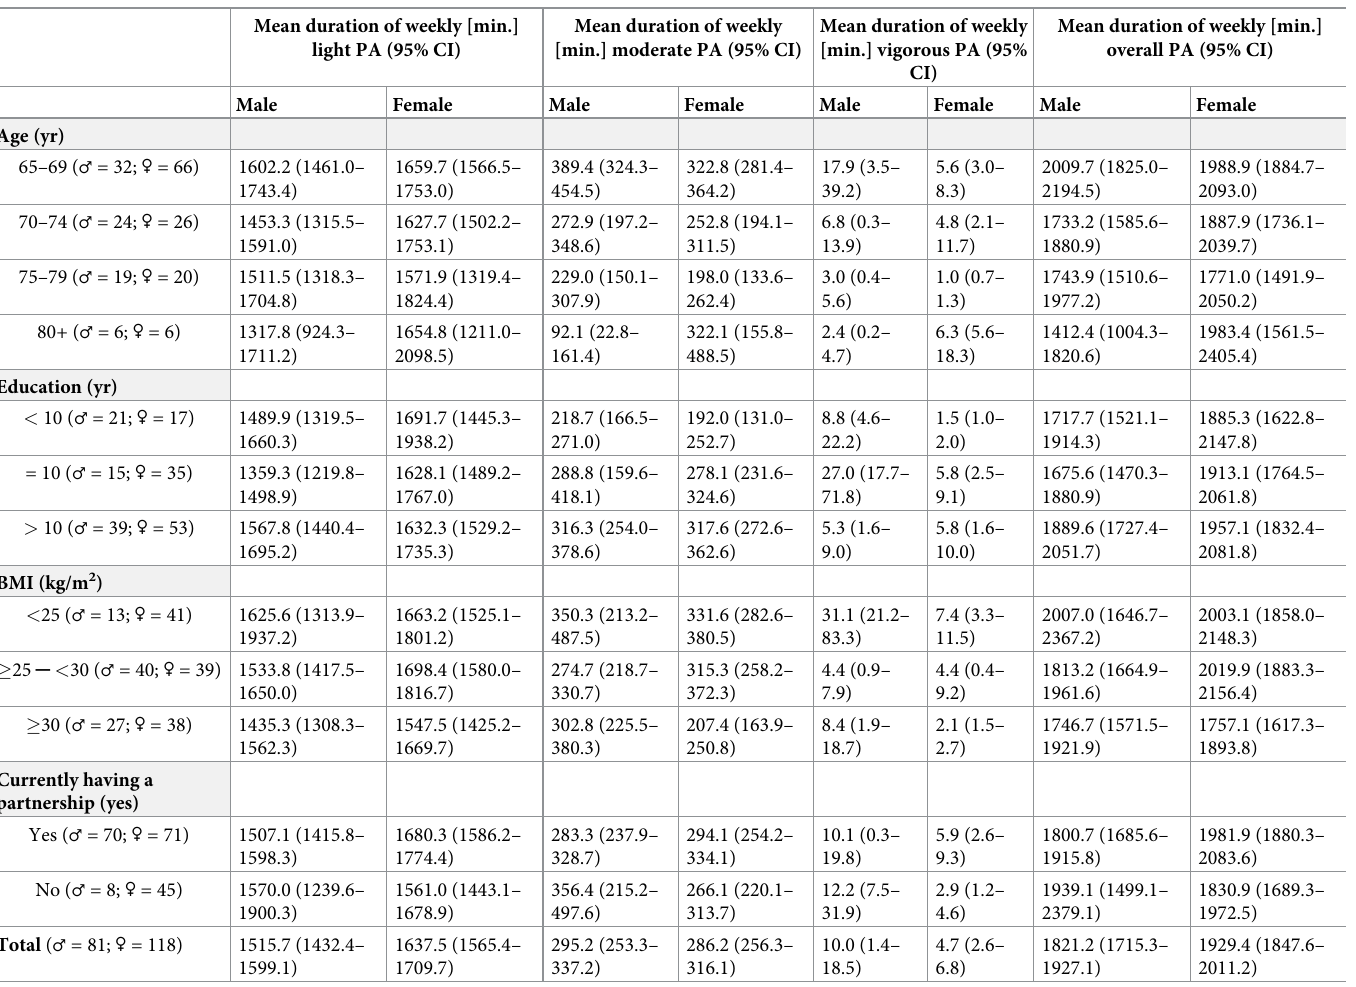
Table 2. Mean duration of weekly PA [min.], without specific cut points, by intensity of PA and overall PA. Mean duration of weekly [min.] light PA (95%